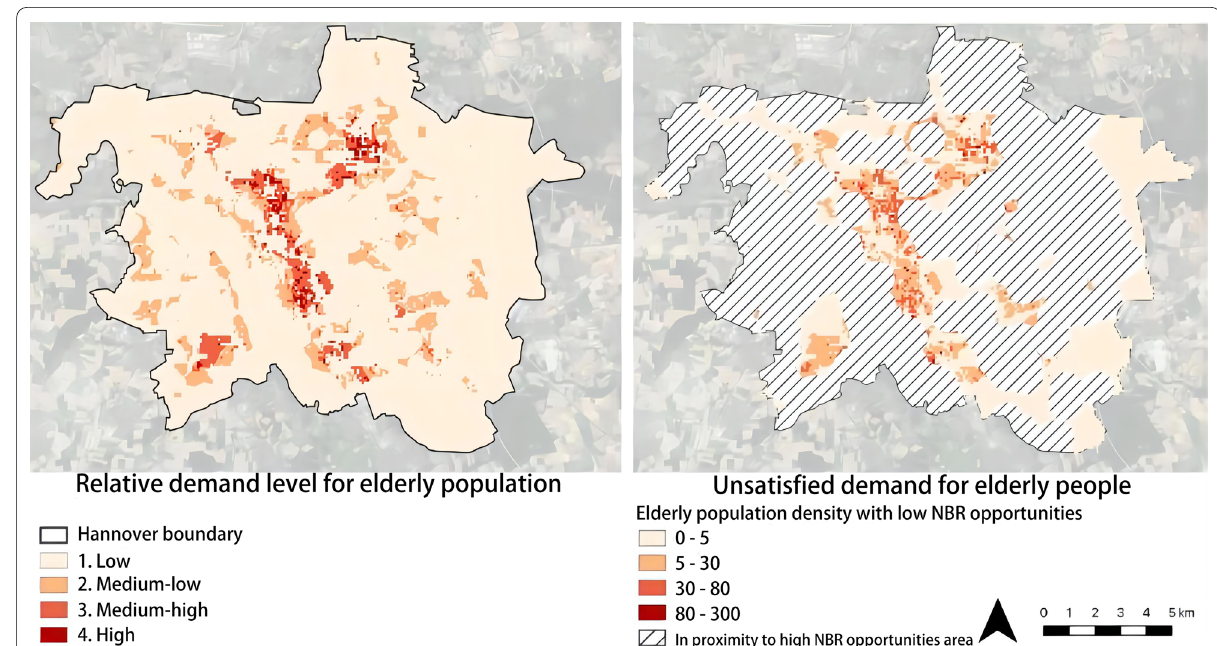
Fig. 9 The modelling results for NBR demand. The left subgraph shows the relative demand level for elderly people, which is determined by the cross-tabulation of elderly population density and the distance the nearest places with high recreational opportunities. The right subgraph shows the unsatisfied demand among the elderly population, indicating the density of the elderly population in areas beyond walking distance to the nearest areas with high recreational opportunities